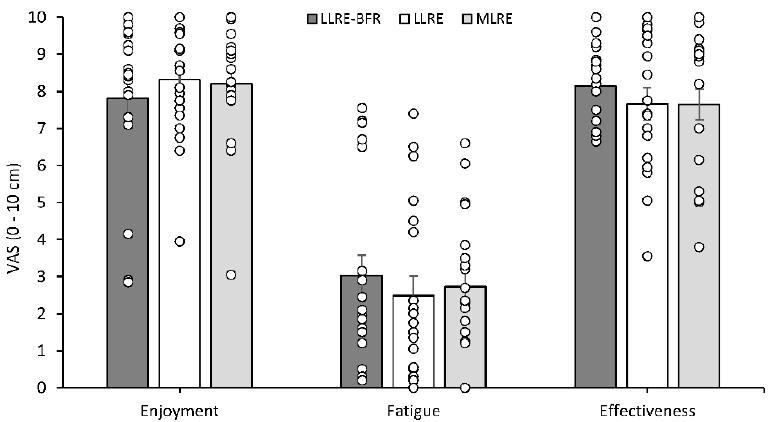
Figure 5. Visual analogue scales of enjoyment, fatigue, and perceived effectiveness recorded 15 min post exercise session. Individual data are displayed to provide information regarding individual responses to exercise.